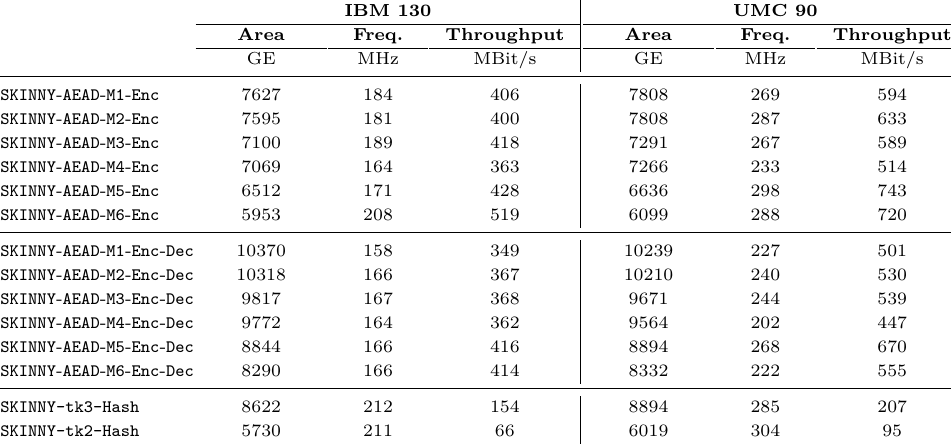
Table 9: Unprotected, round-based ASIC implementations of our SKINNY-AEAD and SKINNY-Hash members using IBM 130 and UMC 90 standard cell libraries.